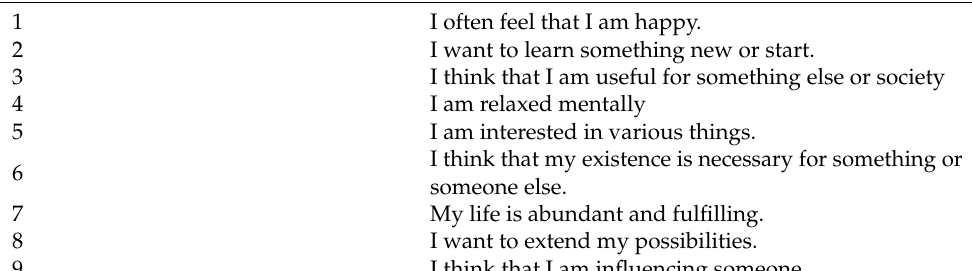
Table 1. Items of